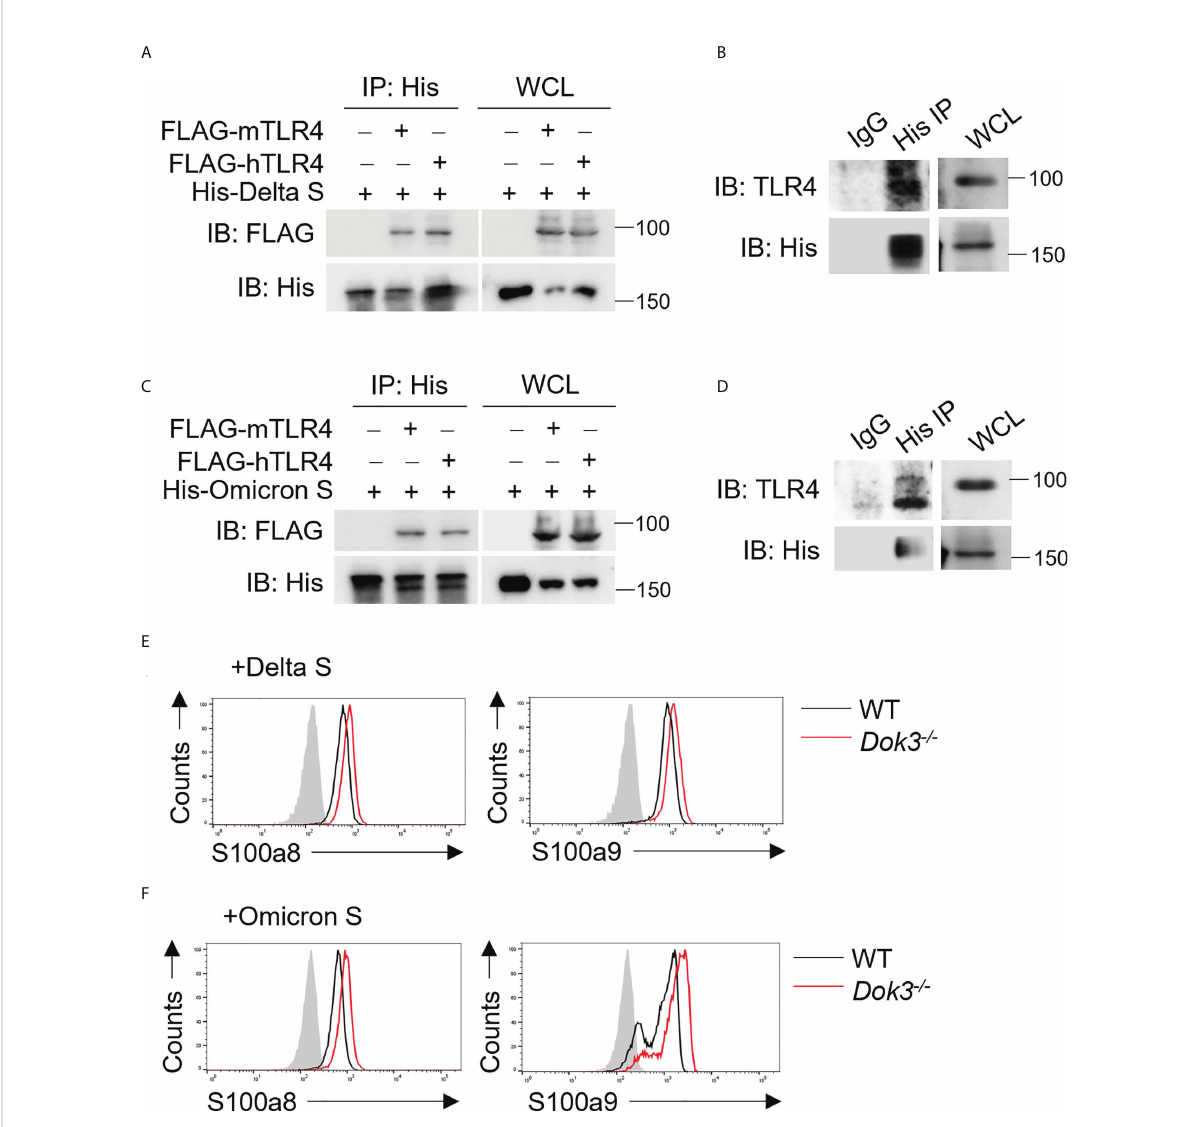
FIGURE 5 SARS-CoV-2 Delta and Omicron variant S proteins can activate TLR4 signaling. (A, C) HEK293T cells were transfected with FLAG-tagged mouse (m) or human (h) TLR4. Cell lysates were incubated with His-tagged S protein derived from (A) Delta or (C) Omicron variant and IP with anti-His antibody overnight. Precipitates and WCL were immunoblotted with anti-FLAG and anti-His antibodies. Data shown are representative of 3 independent experiments. (B, D) WT neutrophils were incubated with His-tagged S protein derived from (B) Delta or (D) Omicron variant and cell lysates were IP with anti-His or IgG control. Precipitates and WCL were probed for TLR4 and His. Data shown are representative of 3 independent experiments. (E, F) Flow cytometric analysis of S100a8 and S100a9 expression in WT and Dok3 -/- neutrophils following 3h stimulation with or without S protein from (E) Delta or (F) Omicron variant. Histograms were pre-gated on singlet, Ly6G + cells. Filled histogram represents isotype control. Data shown are representative of 3 independent